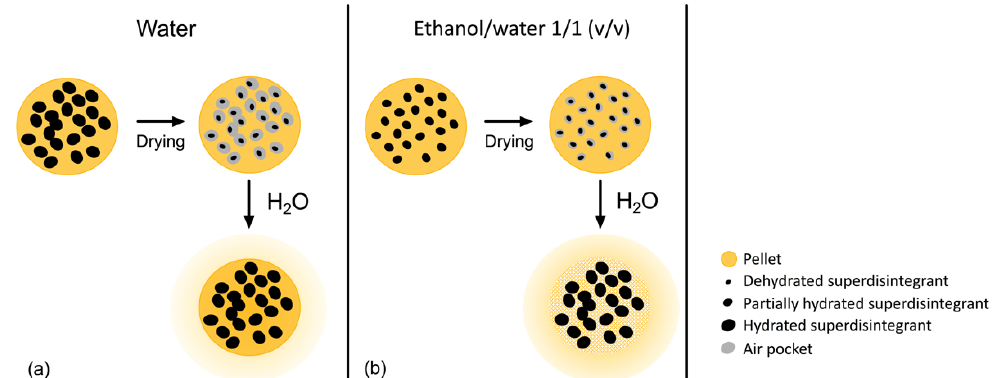
Figure 3. Schematic representation of the influence of the pelletizing liquid during the production process on the disin- tegration behavior of the pellet in aqueous dissolution media. ( a ) Water as a pelletizing liquid leads to air pockets in the dried formulation hampering disintegration during dissolution; ( b ) ethanol/water 1/1 ( v/v ) as a pelletizing liquid leads to smaller air pockets in the dried formulation enabling disintegration during